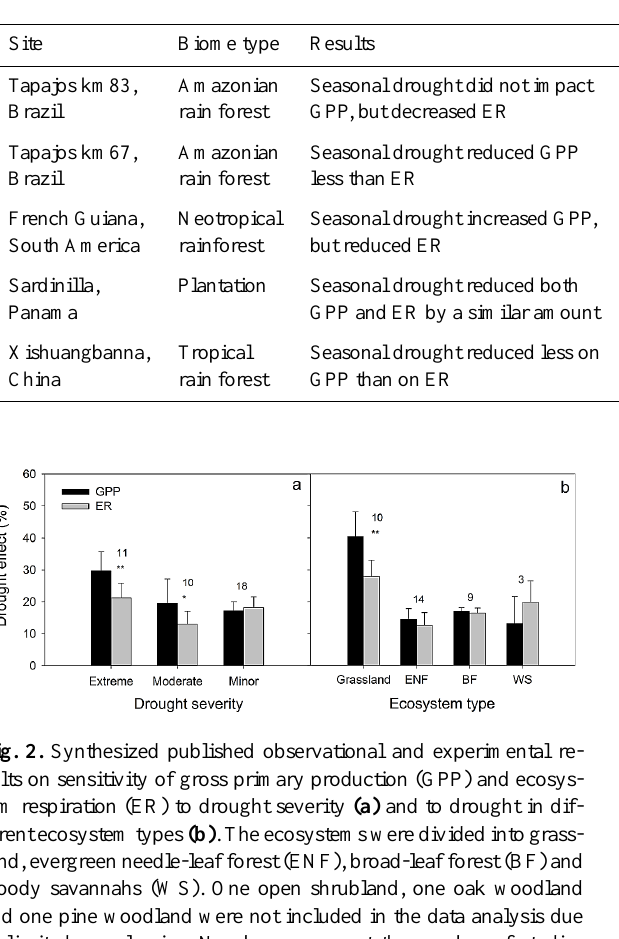
Fig. 3. Drought-induced reductions in modeled annual NPP, R h , NEE and soil C content over time in four North American grass- lands (Konza: a , e , i and m ; Hays: b , f , j and n ; Cheyenne: c , g , k and o ; Sevilleta: d , h , l and p ). Absolute reduction in NEE was calculated as the difference in NEE between drought treatments and ambient condition. Relative reduction in NPP, R h and soil C content were presented and calculated as absolute reduction divided by am- bient condition. Differential effects of long-term droughts diminish over time as soil C content